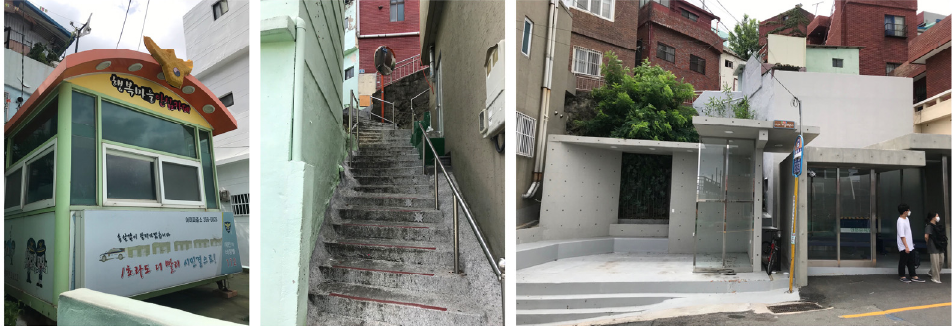
Figure 8. Police kiosk, street safety measures and village bus stop.